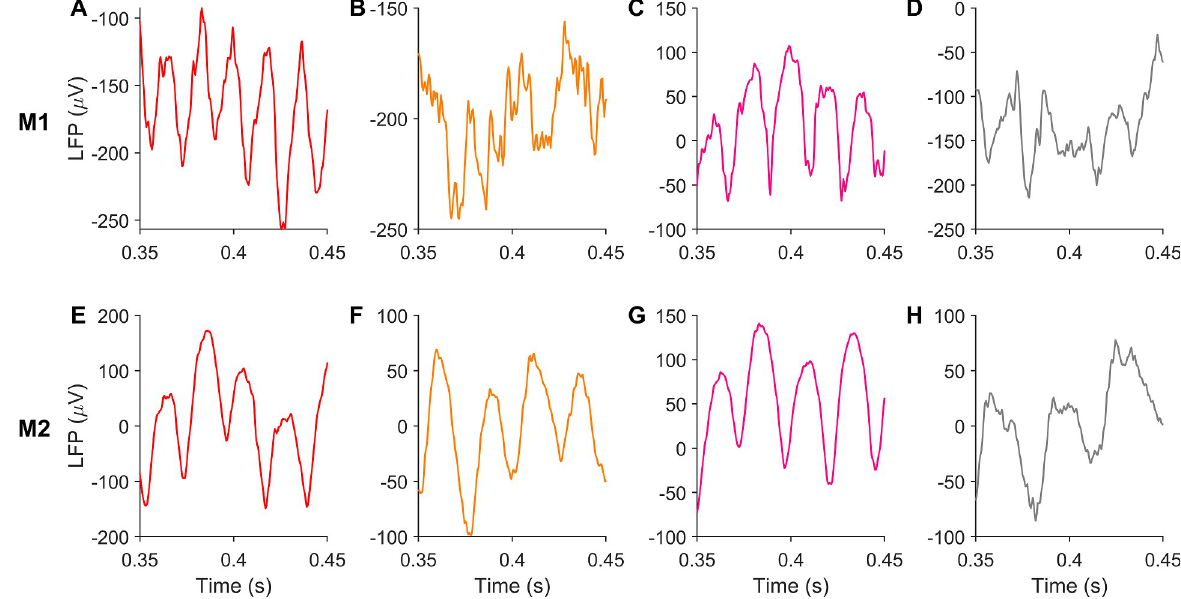
Fig 3. Gamma waveform has consistent non-sinusoidal shape under different stimuli. (A-D) present LFP traces for different stimuli, shown in Fig 1, from an example trial and electrode in M1. (E-H) shows LFP traces obtained from M2 for corresponding stimuli.